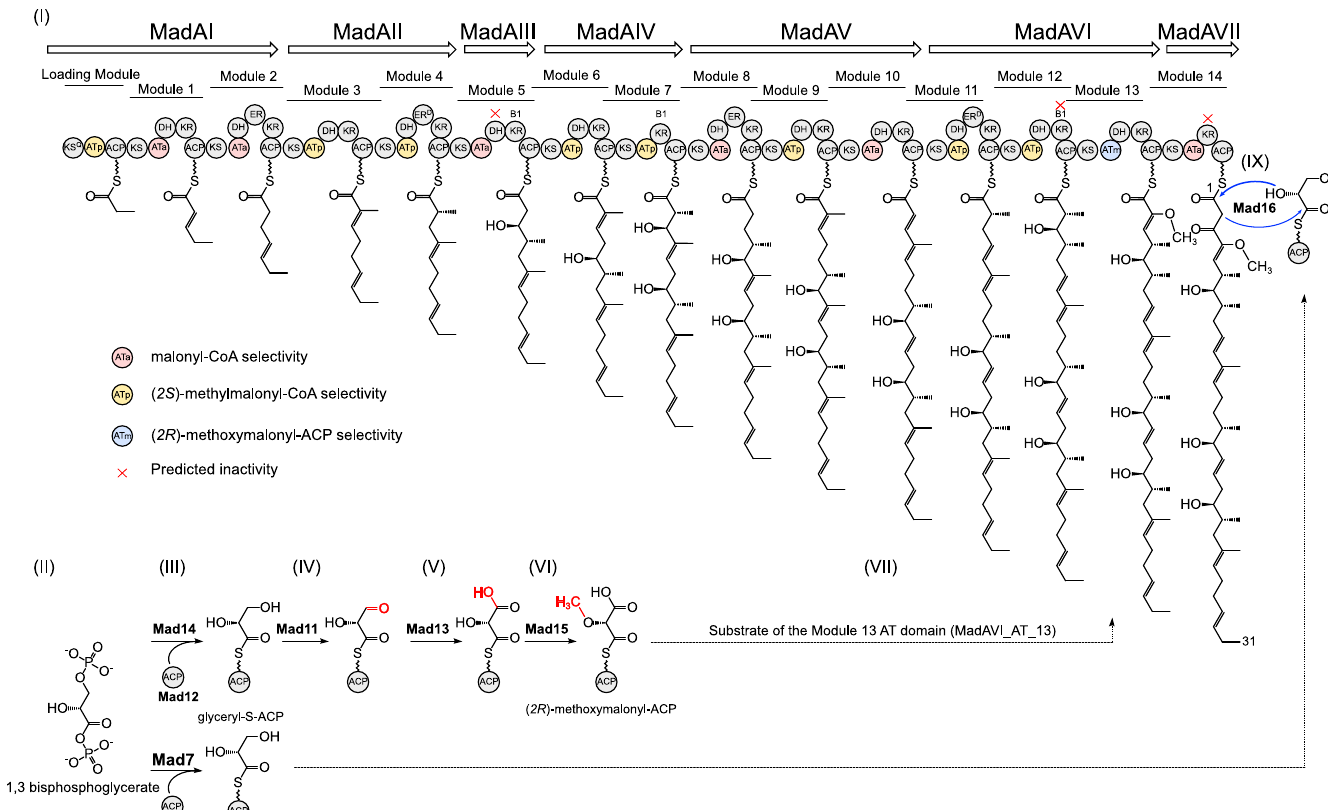
Fig 4. The proposed biosynthesis pathway of tetromadurin (part 1). (I) The seven PKS enzymes (MadAI-MadAVIII) and predicted linear tetromadurin intermediates of the mad gene cluster. ATa domains contain the amino acid motifs associated with malonyl-CoA (acetate unit) incorporation. ATp domains contain the amino acid motifs associated with (2S)-methylmalonyl-CoA (propionate unit) incorporation. The ATm domain is predicted to recognise ( 2R )-methoxymalonyl-ACP. ER D domains are predicted to create a D-configured α -methyl group. B1 KRs are predicted to create D-configured α -methyl and β -hydroxyl groups. The KS domain in MadAI is a KS Q domain. The red crosses indicate domains that are predicted to be inactive on the basis of their amino acid sequence. (II) The key biosynthetic precursor 1,3-bisphosphoglycerate, involved in both tetronate formation and ( 2R )-methoxymalonyl-ACP biosynthesis. (III) Formation of glyceryl-ACP by the FkbH-like enzyme Mad14 and the ACP Mad12. (IV) Oxidation of glyceryl-ACP by the dehydrogenase Mad11 to form 2-hydroxy-3-oxopropionyl-ACP. (V) Oxidation of 2-hydroxy- 3-oxopropionyl-ACP by the dehydrogenase Mad13 to form hydroxymalonyl-ACP. (VI) Methylation of hydroxymalonyl-ACP by the O -methyltransferase Mad15 to form ( 2R )-methoxymalonyl-ACP. (VII) The ( 2R )-methoxylmalonyl-ACP is incorporated by the MadAVI_AT_13. (VIII) Synthesis of a second pool of glyceryl-ACP by FkbH-like Mad7 and ACP Mad8. (IX) Glyceryl-ACP is a substrate of the FabH-like protein Mad16 that catalyses tetronate formation and concomitant chain release from the PKS. Bonds/atoms have been coloured red to highlight the chemical